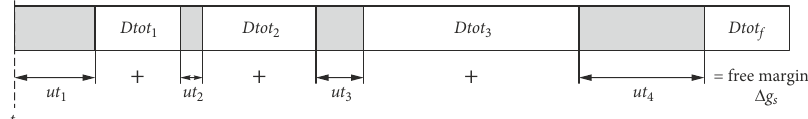
Figure 6. Illustration of case III of shop scheduling under emergency events Table 1. Model III decision variables and